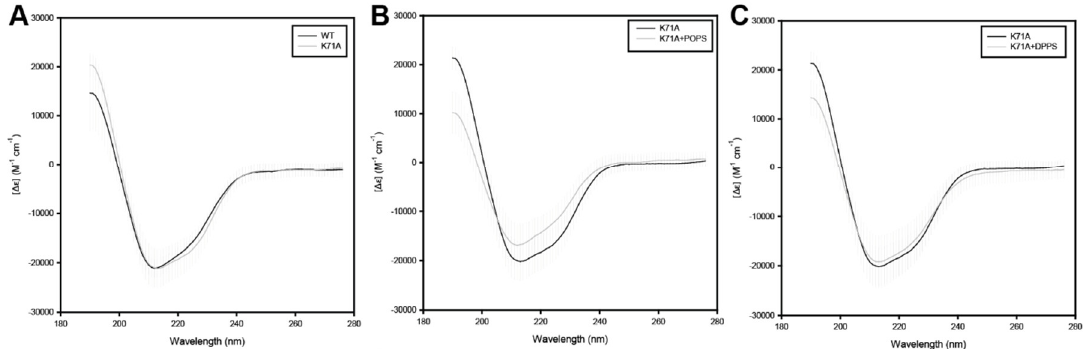
Figure 6. Circular dichroism (CD) experiments reveal subtle alterations of the secondary structure of the K71A mutated HspA1A in the presence of different lipids. Mean residue CD extinction coefficient values (Δε in Μ −1 ·cm −1 ) were plotted and analyzed using the CD Analysis and Plotting Tool. Experiments were performed using three different protein batches, and the bars represent SD. The graphs compare the Δε values between wild-type HspA1A and K71A without liposomes ( A ), and K71A HspA1A supplemented with ( B ) POPS, and ( C ) DPPS liposomes.